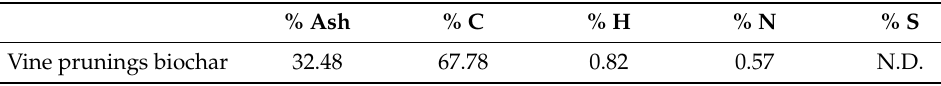
Table 1. Ultimate analysis of dry vine pruning biochar.